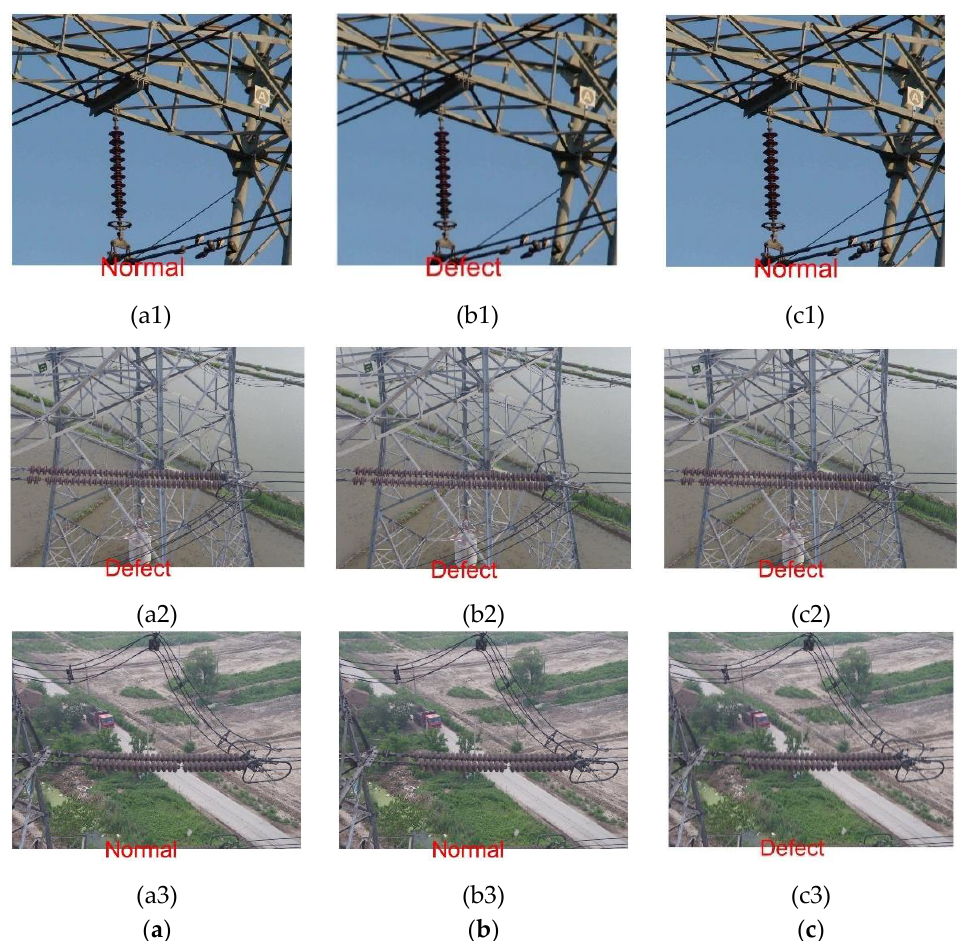
Figure 12. Classification results of each model for image recognition ( a ) SVM; ( b ) Random Forest; ( c ) PSO-SVM.